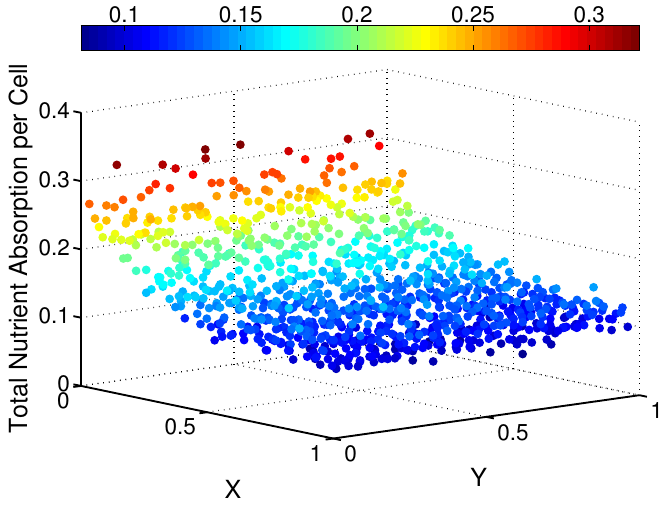
Figure 6. Illustration of the total nutrient consumed by each cell in the cell-seeded scaffold ( Ω ) for the case b = 0 . 5 2